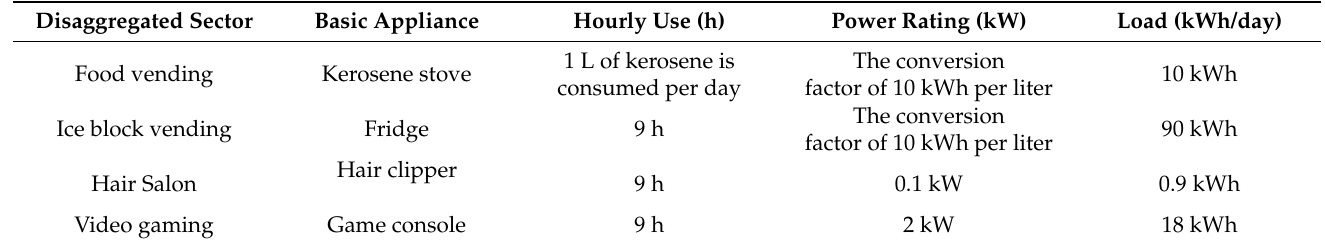
Table 14. Results from the survey on category A productive use